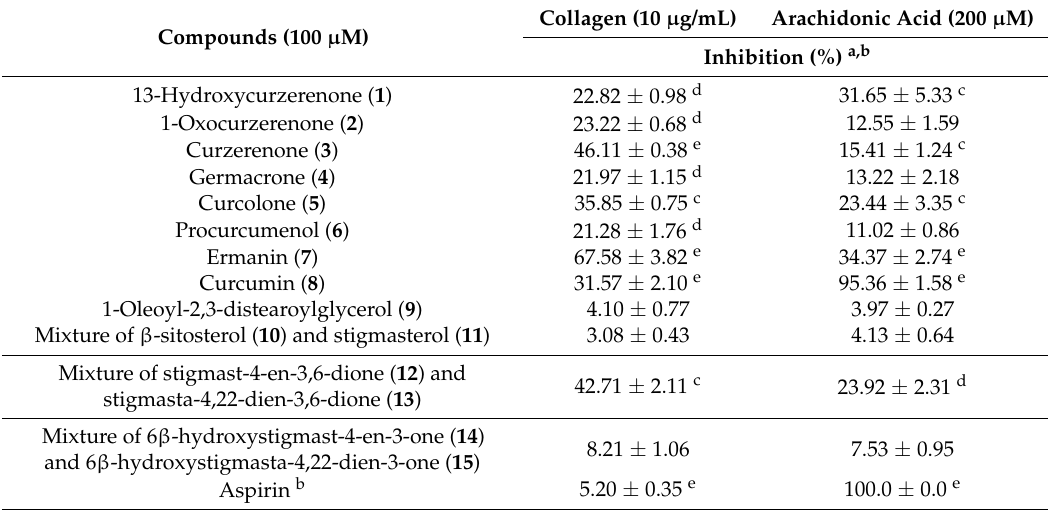
Table 2. Inhibitory effects of compounds on the aggregation of washed rabbit platelets induced by collagen and arachidonic acid (AA) a